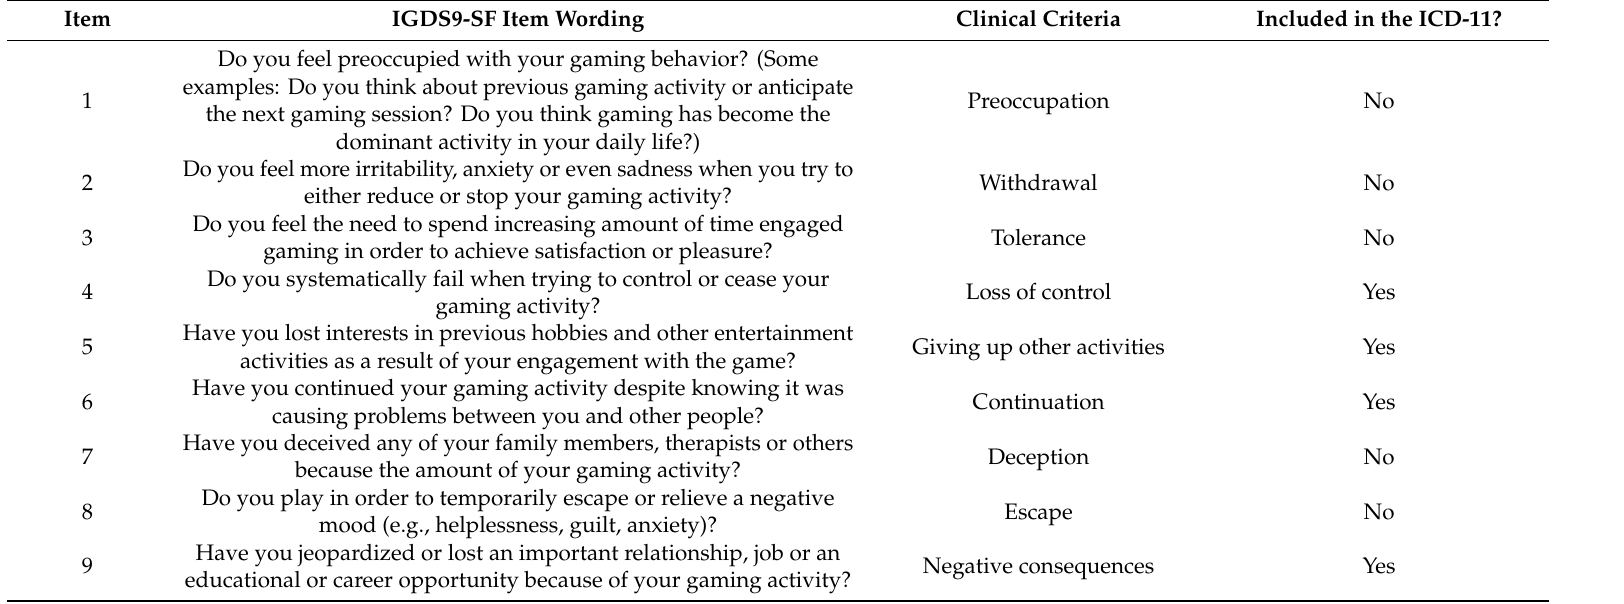
Table 1. The operationalization of video game addiction according to the nine Internet Gaming Disorder (IGD) as measured with the Internet Gaming Disorder Scale–Short-Form (IGDS9-SF), their corresponding clinical criteria and comparison against the criteria for gaming disorder within the 11th International Classification of Diseases